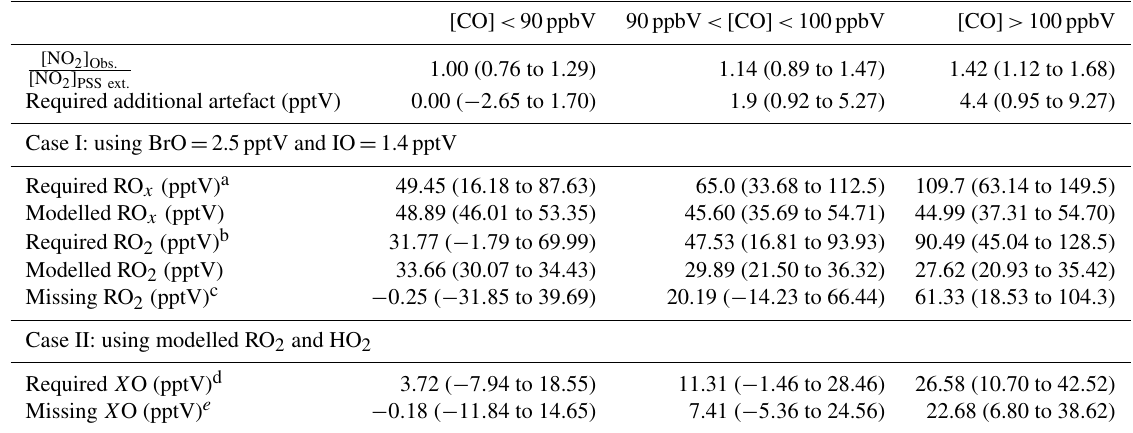
Figure 6. Density distributions of (a) [NO 2 ] Obs . / [NO 2 ] PSS ext . , (b) unaccounted RO 2 , and (c) unaccounted X O separated by measured CO mixing ratios. An NO 2 artefact of 0.7pptV has been subtracted from all data. Table 4. Summary over the required additional artefact, RO 2 , and X O to give [NO 2 ] Obs . / [NO 2 ] PSS ext . = 1 given as 50th (25th–75th) percentile when subtracting a NO 2 artefact of